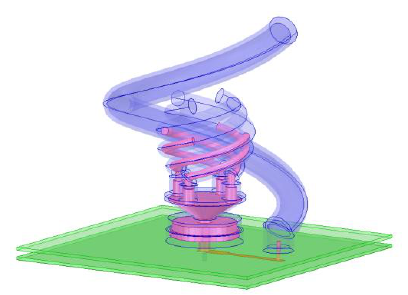
Figure 21. Diagram of State-V with liquid metal filled in.